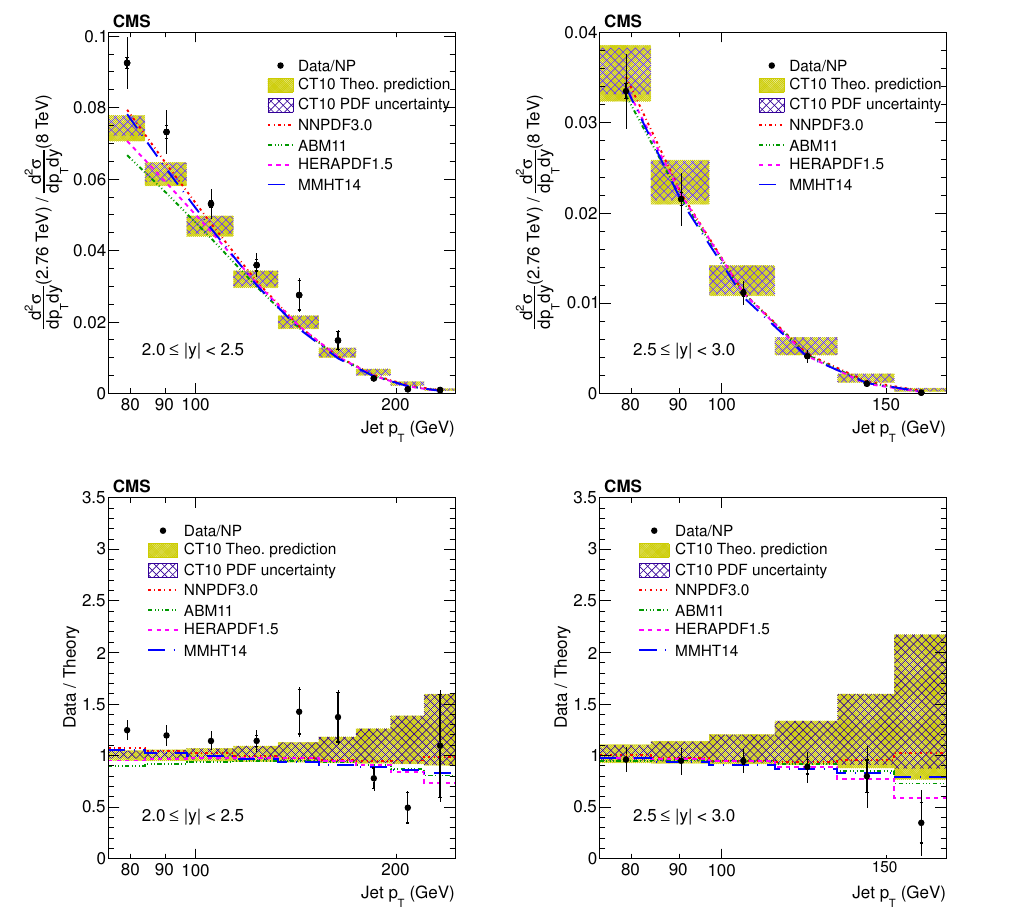
p s = 2.76 and 8 TeV shown